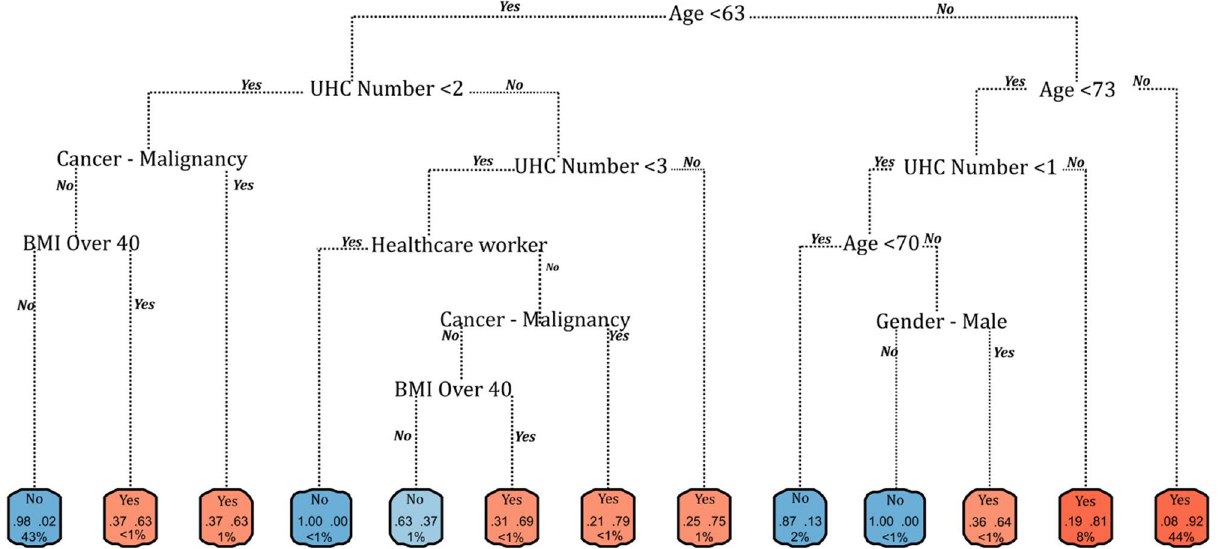
Figure 6. Recursive partitioning and regression tree (rtree) model for mortality among symptomatic COVID- 19 cases in the Republic of Ireland, February to November